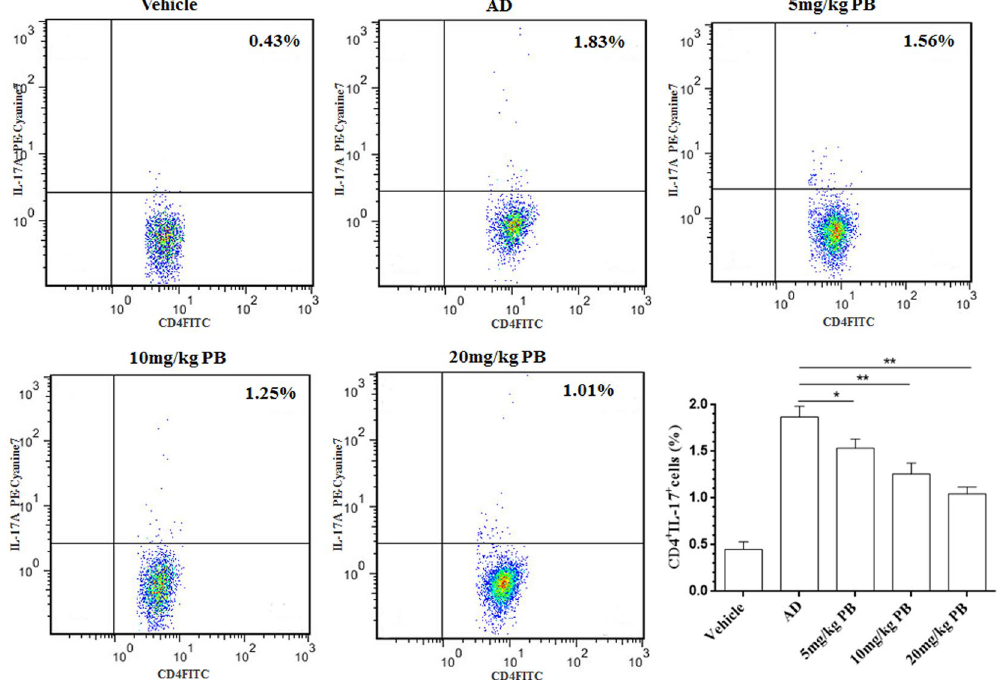
Figure 5. Down-regulation of PB on Th17 cells in NC/Nga mice. Cells collected from the draining lymph nodes of NC/Nga mice were stained and determined by flow cytometric analysis as showed in methods. Representative fluorescence-activated cell sorting plots showing the frequency of IL-17A-producing cells within the population of CD4 + T cells. Numbers in the dot plots represented the percentages of Th17cells. Data are representative of two independent experiments and presented as mean ± SD of n = 8 mice per group. * p < 0.05, ** p < 0.01. Vehicle, intact mice with saline treatment; AD, DNFB-sensitized and challenged mice; PB, pseudolaric acid